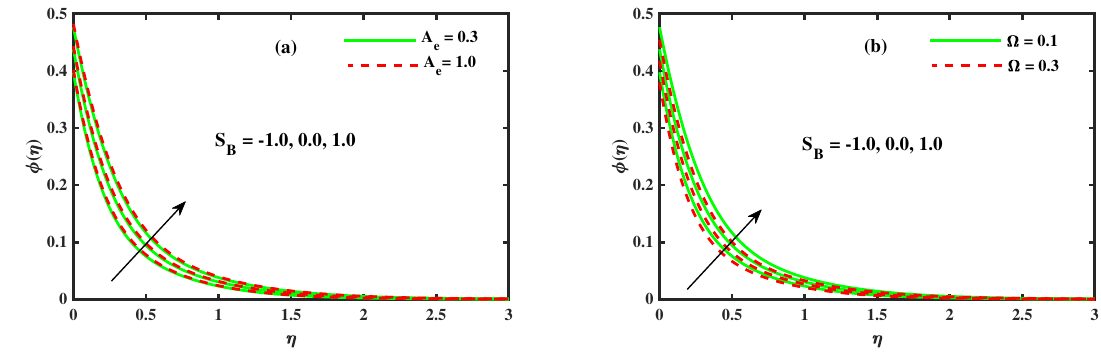
Figure 12. The impact of φ ( η ) for ( a ) activation energy A e and ( b ) chemical reaction rate Ω . Figure 13a,b demonstrate the behavior of the nanoparticles concentration profile with different values of the Schmidt number Sc, Buoyancy ratio parameter N r and Stefan blowing parameter S B . The Schmidt number Sc impact on the nanoparticle concentration diagram is portrayed in Figure 13a. Expanding the Schmidt number relates to a low Brownian dispersion coefficient, which prompts short entrance profundity for the concentration profile. Subsequently, the concentration at the surface abates with the expanding impact of the Schmidt number. Figure 13b illustrates the result of N r on φ ( η ) . The concentration profile boots up by increasing N r .